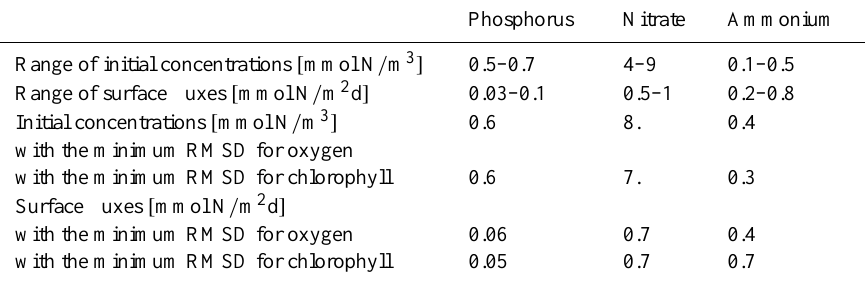
Table 2. Ranges of initial concentrations and surface fluxes of limiting nutrients used in the sensitive analysis and the corresponding values, for which the minimum of the RMSD has been